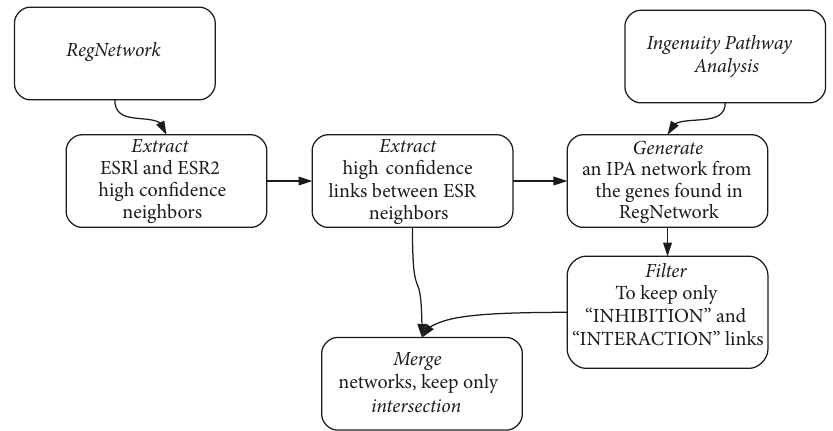
Figure 1: Pipeline followed in this work.